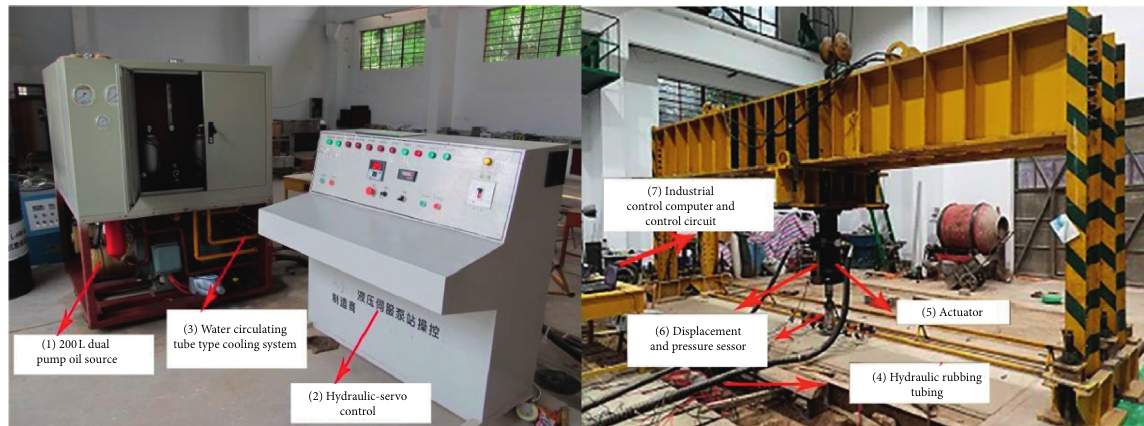
Figure 7: YX1200 pavement electrohydraulic servo fatigue test system.